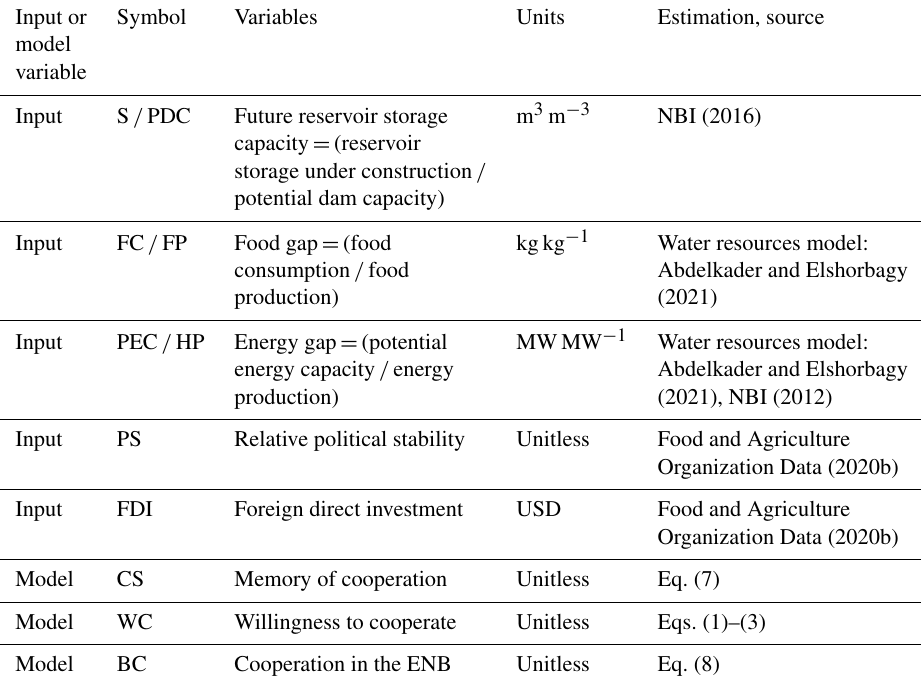
Table 1. Input variables and model variables. All variables have an annual resolution (with the exception of potential energy capacity and potential dam capacity which are single values) and are specified for Ethiopia, Sudan, and Egypt independently.